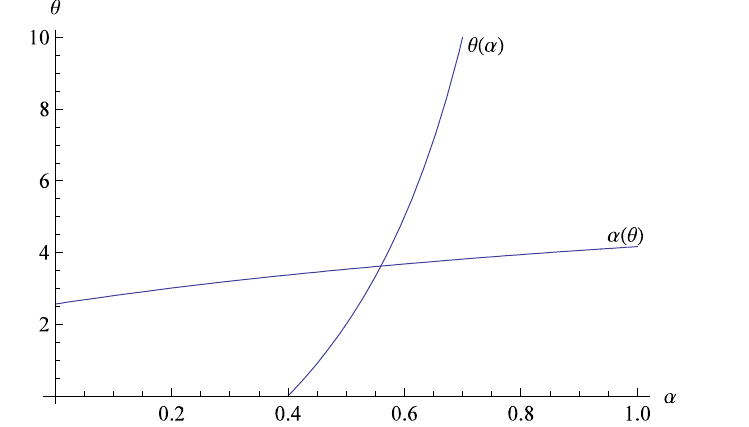
Fig. 1 Reaction functions of the seller, θ ( α ), and the buyer group, α ( θ ). Parameter values: z (cid:4) 1.4 and s (cid:4) 0.6